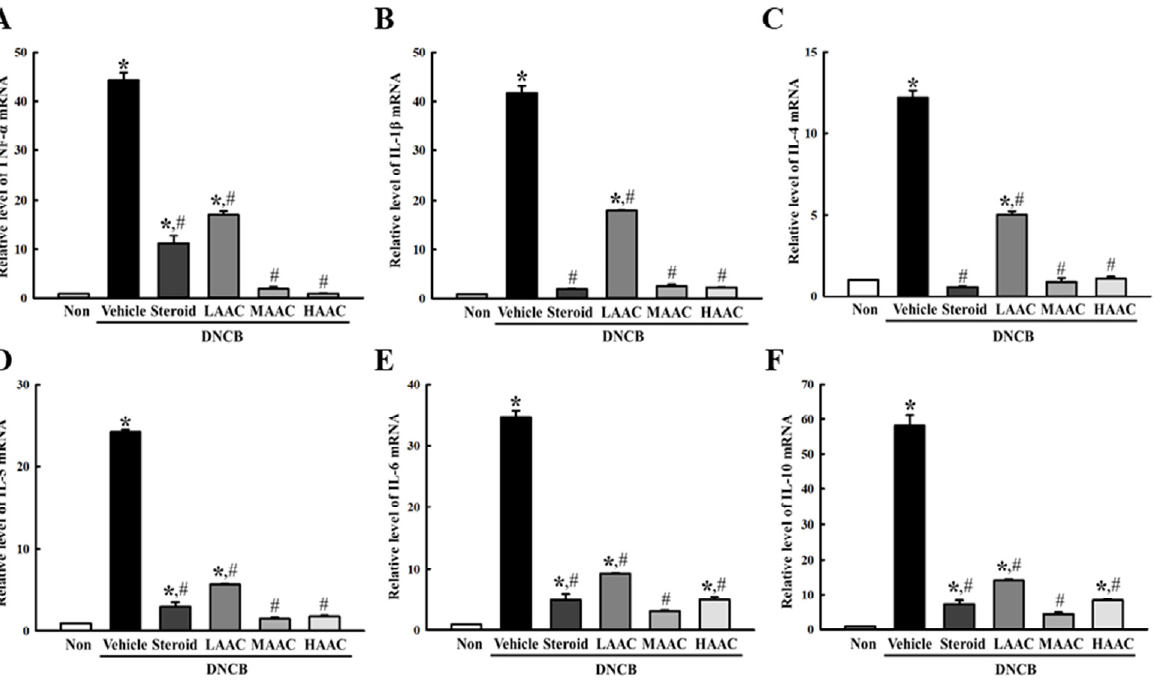
Figure 11. Level of inflammatory cytokines in DNCB-treated BALB/c mice spread with AAC. The levels of ( A ) TNF- α , ( B ) IL-1 β , ( C ) IL-4, ( D ) IL-5, ( E ) IL-6, and ( F ) IL-10 transcripts were measured in the total mRNA of DNCB+AAC-treated BALB/c mice by RT-qPCR using specific primers. The mRNA levels of the six genes were calculated based on the intensity of actin as an endogenous control. Total RNA was prepared from four to six mice per group, and RT-qPCR analyses for each sample were analyzed in duplicate. All values in the results are represented as the means ± standard deviation (SD). * indicates statically significance compared to the non-treated group, while # indi- cates statistical significance compared to the DNCB+Vehicle-treated group. Abbreviations: AA, ab- ietic acid; DNCB, 2,4-dinitrochlorobenzene; LAAC, low concentration of AA cream; MAAC, me- dium concentration of AA cream; HAAC, high concentration of AA cream; TNF- α , tumor necrosis factor alpha; IL, interleukin.